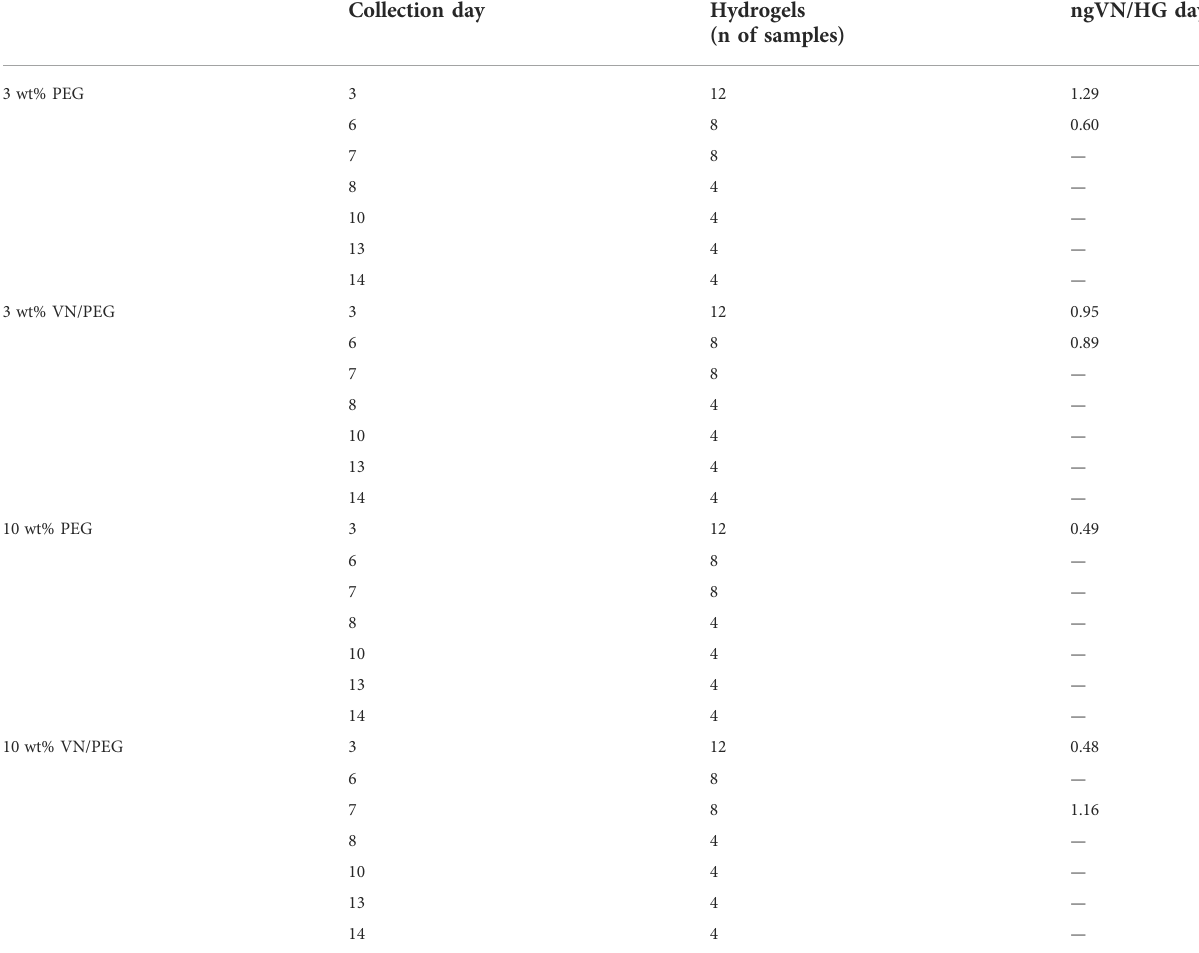
TABLE 1 Summary of ELISA assay for secreted VN detection in the culture media at different time points. VN detected values are referred as ng of VN secreted per hydrogel each day. Collection